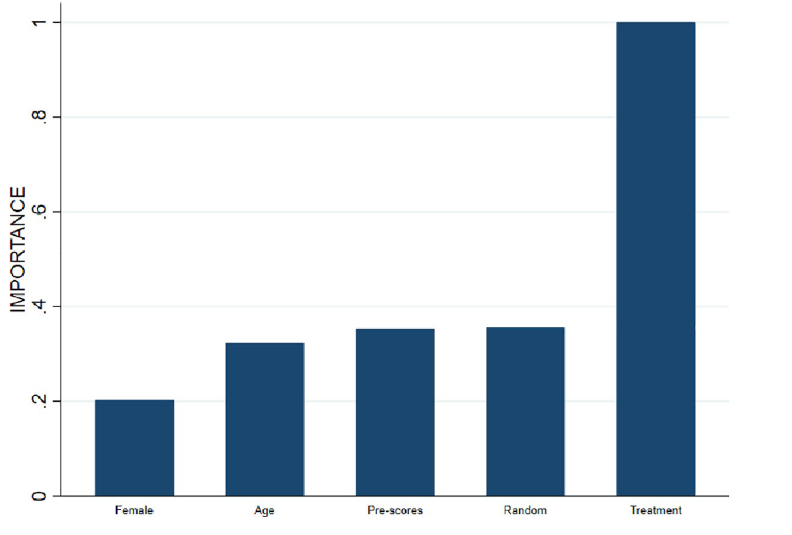
Fig 3. Importance graph attrition